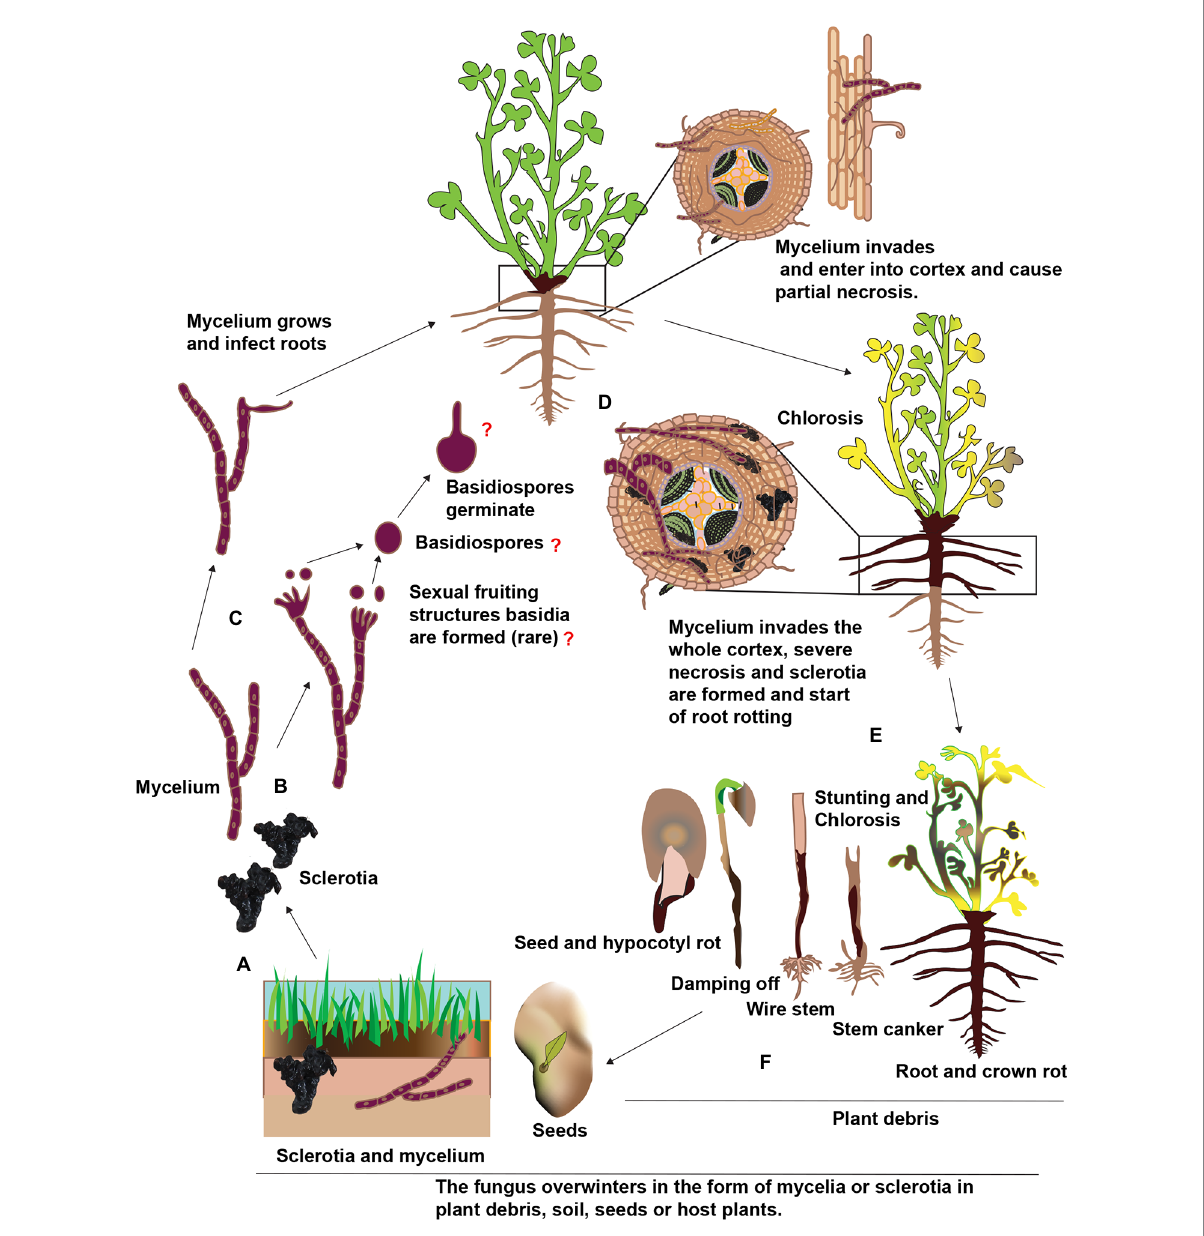
FIGURE 5 Schematic representation of the presumed disease cycle of Rhophitulus solani root rot in China. (A) , The fungus overwinters in the plant debris and seeds in the form of mycelium and in the soil as sclerotia and mycelium. (B,C) The young hyphae germinate and develop under favorable conditions, sexual fruiting structures basidia and basidiospores are rare. (D) The mycelium penetrates roots near the soil line and colonized in inter and intracellular spaces. (E) The mycelium proliferates further in the cortex ultimately results in necrosis and sclerotia are formed in and on infected tissues and disintegration and acute rotting of roots. (F) Above ground symptoms, include chlorosis, blights, stunting and finally death, the fungus also infects seeds and seedlings and also causing